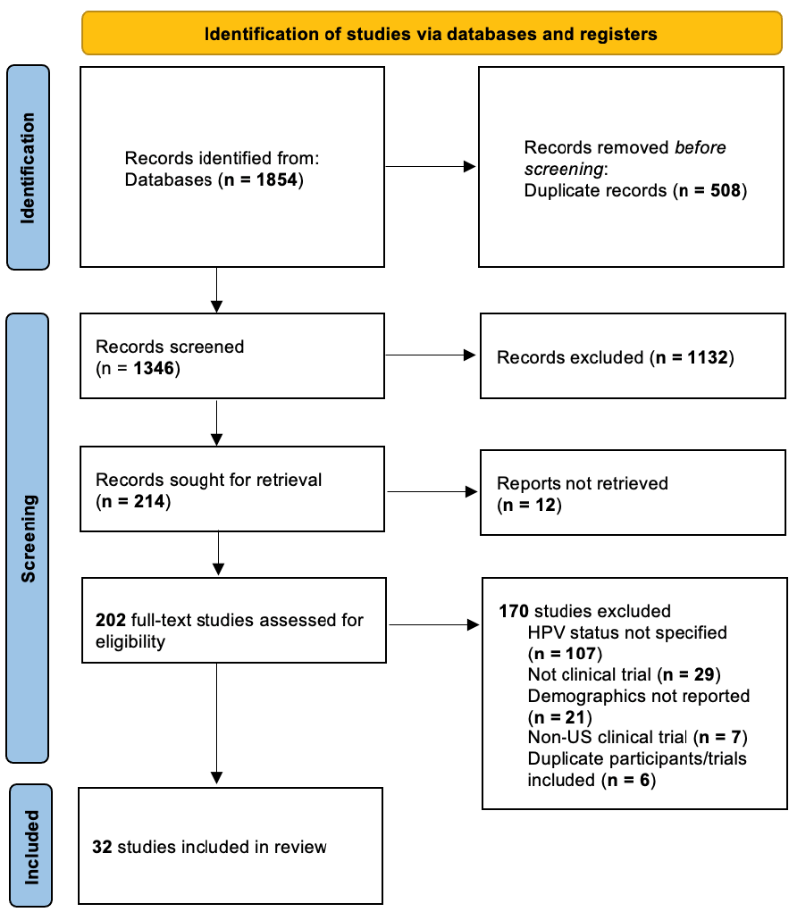
Figure 1. Preferred Reporting Items for Systematic Reviews and Meta-Analysis (PRISMA) flowchart for data search performed in PubMed (National Library of Medicine, National Institutes of Health), Scopus (Elsevier), CINAHL (EBSCO), and Cochrane Library (Wiley). Table 1. Clinical trial characteristics *.